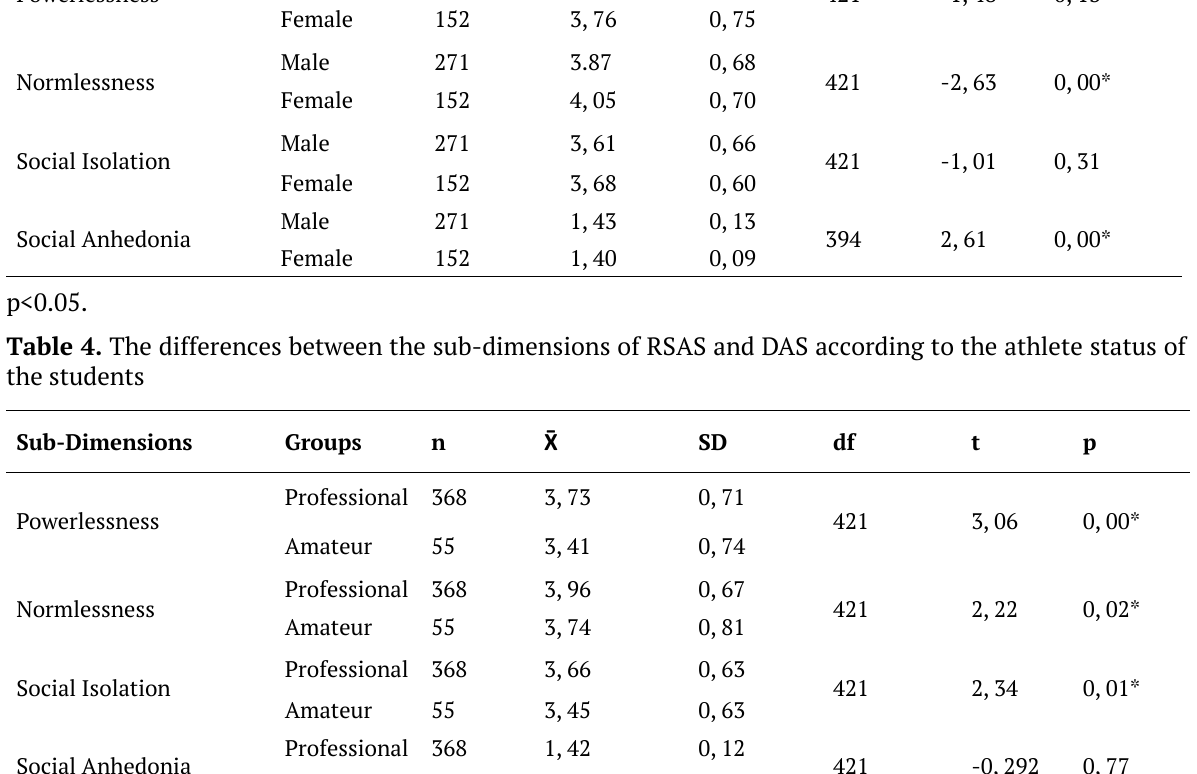
Table 3. Differences between the sub-dimensions of RSAS and DAS according to the gender of the students Sub-Dimensions